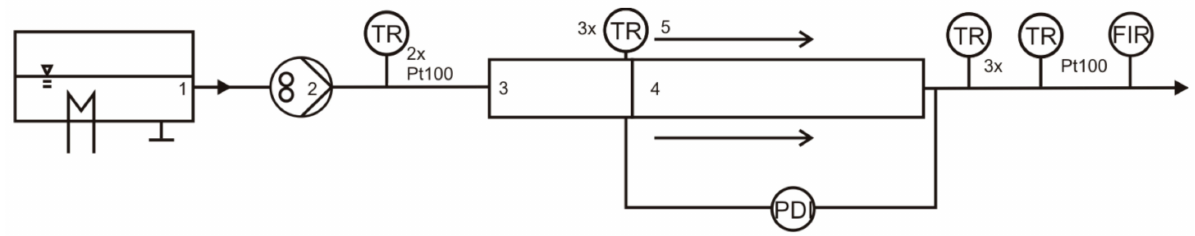
Figure 2. Process flow diagram of the test facility: 1, thermostat; 2, gear pump; 3, inlet section; 4, test section; 5, cold co-current flow to develop thermal boundary condition desired. Reproduced with permission from [16], published by Elsevier